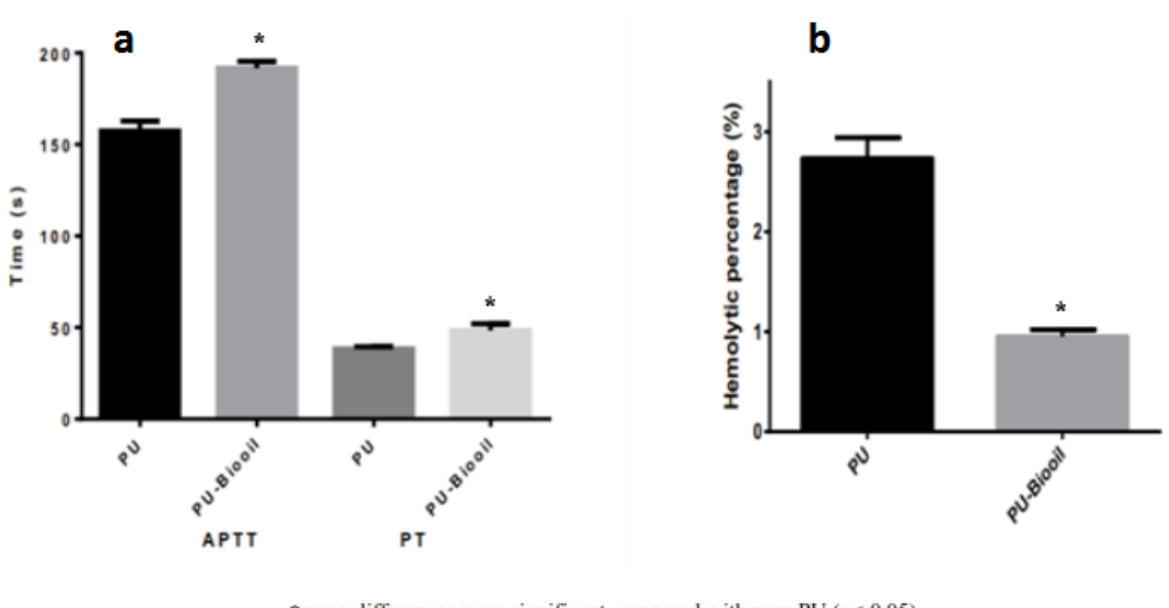
Figure 6 - a ) APTT and PT assay of Pure Polyurethane and PU/bio oil TM composites and b ) Hemolysis assay of PU and PU/bio oil TM